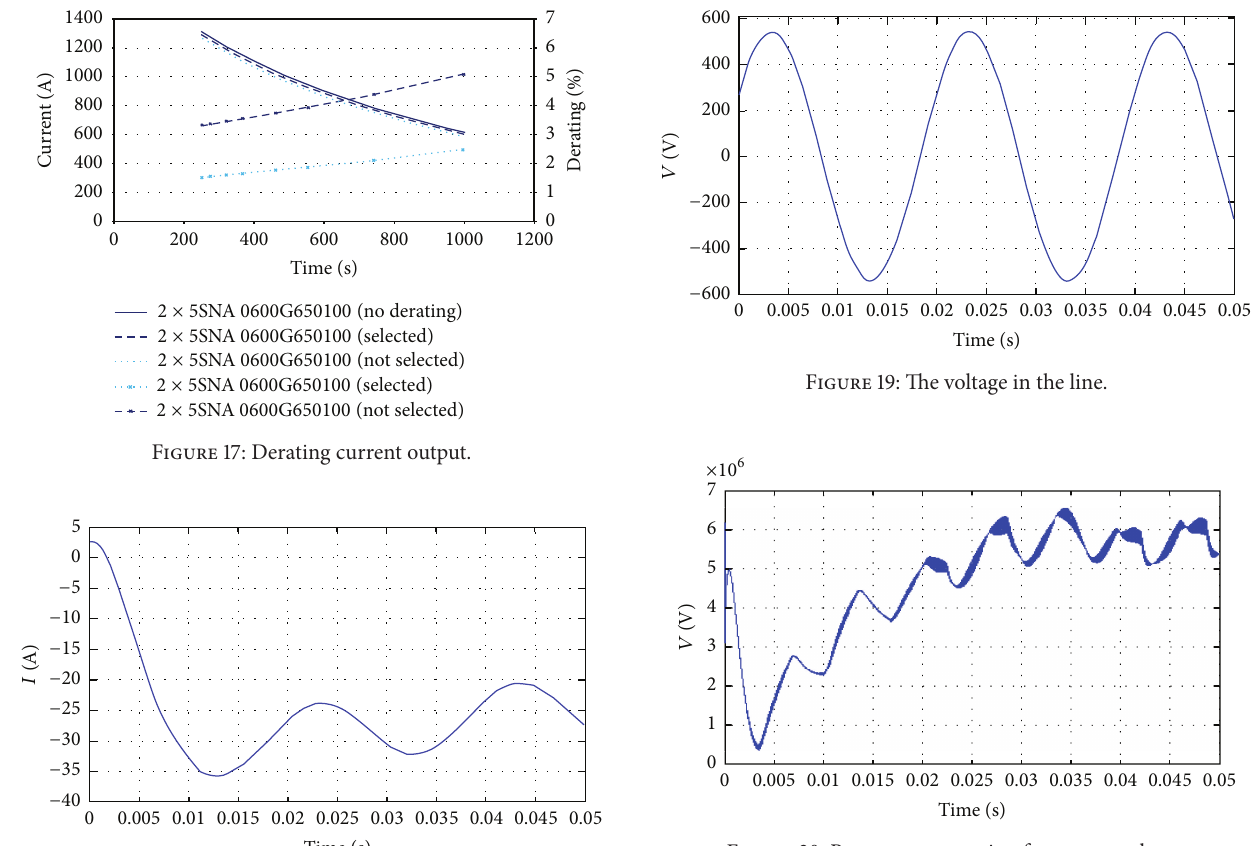
Figure 20: Power compensation for output voltage.